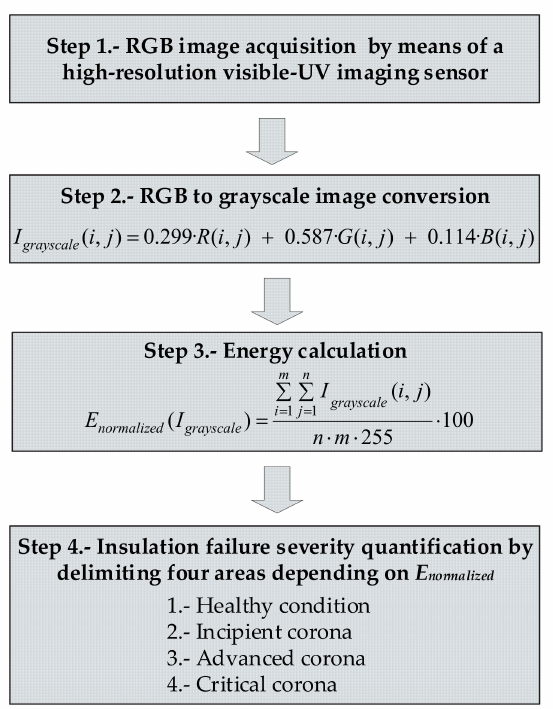
Figure 2. Process diagram to determine the severity of the insulation